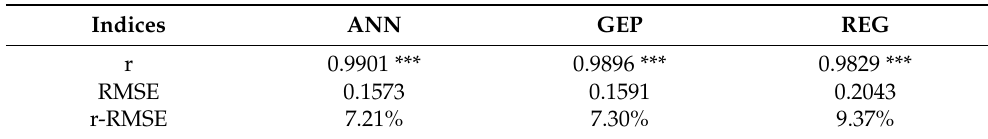
Table 2. Model performances on model testing phase show the similarity between two AI-based ANN and GEP models. Indices ANN GEP REG r 0.9901 *** 0.9896 *** 0.9829 *** RMSE 0.1573 0.1591 0.2043 r-RMSE 7.21% 7.30% 9.37% ***: The symbol denotes significant correlation at p < 0.0001.